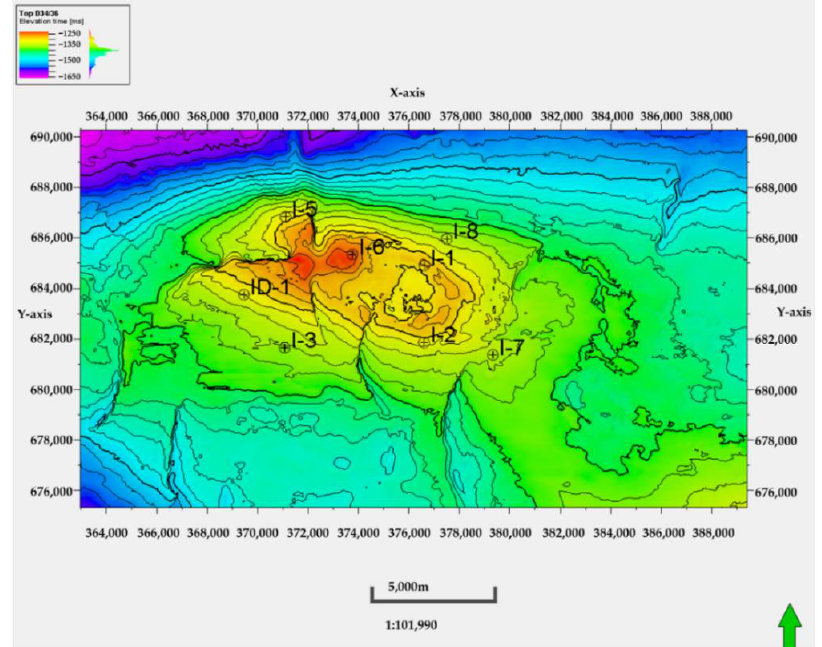
Figure 7. D34/36 formation of time structure base map of the study area. The base map shows the surface seismic and well locations.